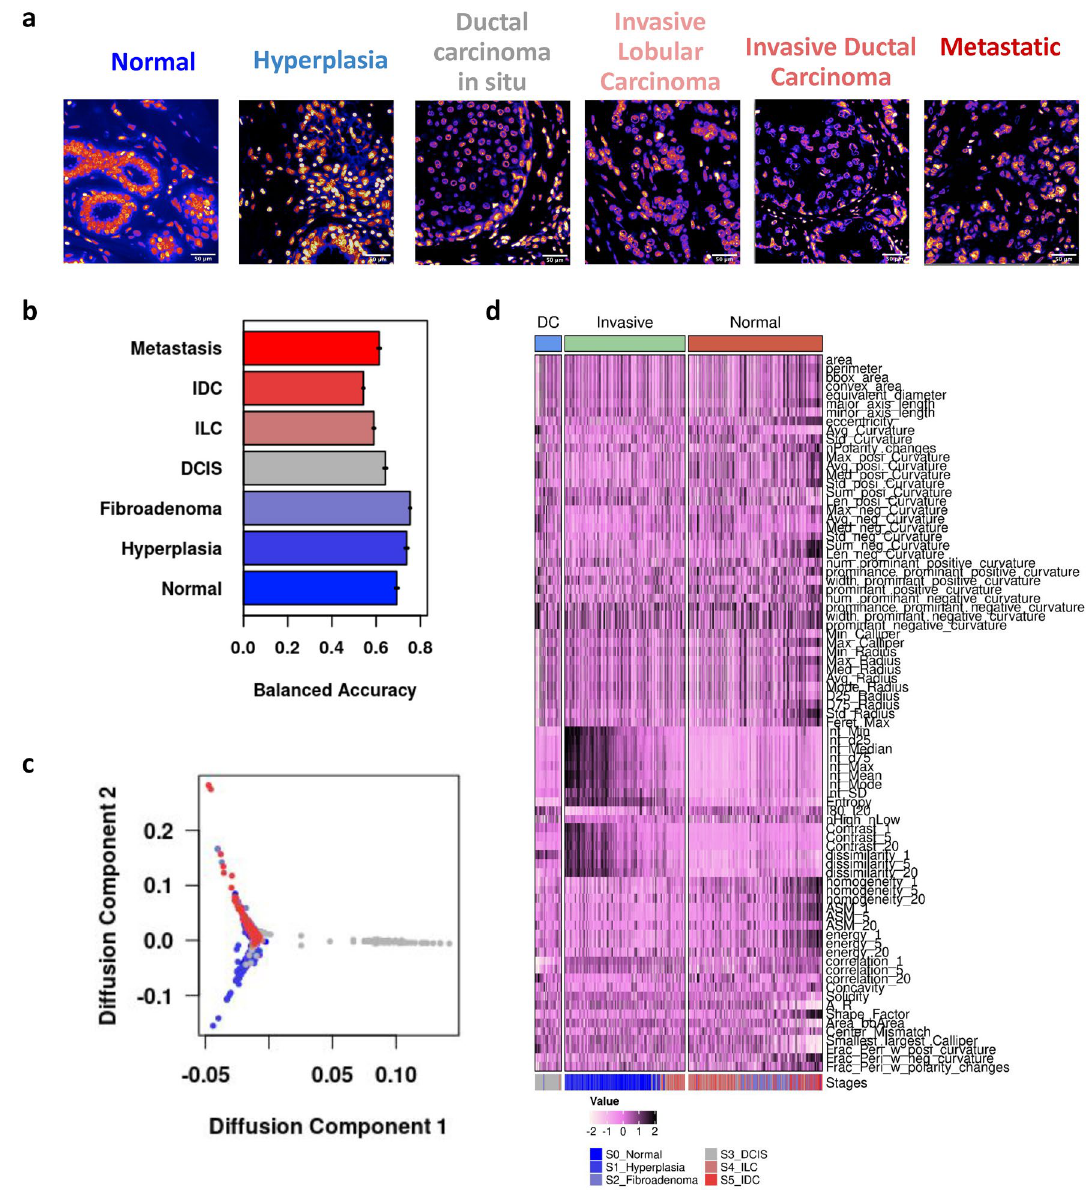
Figure 3. Building a trajectory of chromatin reorganization associated with breast cancer progression. ( a ) Representative crops of Hoescht -stained tissue biopsy images of different stages of breast cancer. ( b ) Prediction accuracy of the linear discriminant classifier on the test dataset. Error bars denote the standard error of classification in across 5 cross validation tests. ( c ) Diffusion Map of nuclei from various stages of cancer. Each dot represents one cell and the color code is displayed as an inset. ( d ) Heatmap depicting the branch-wise changes to representative nuclear morphology and chromatin organization features. The color code is indicated near the bottom. Note that each column represents a single cell. The column-side color bar at the bottom of the heatmap represents the stage of